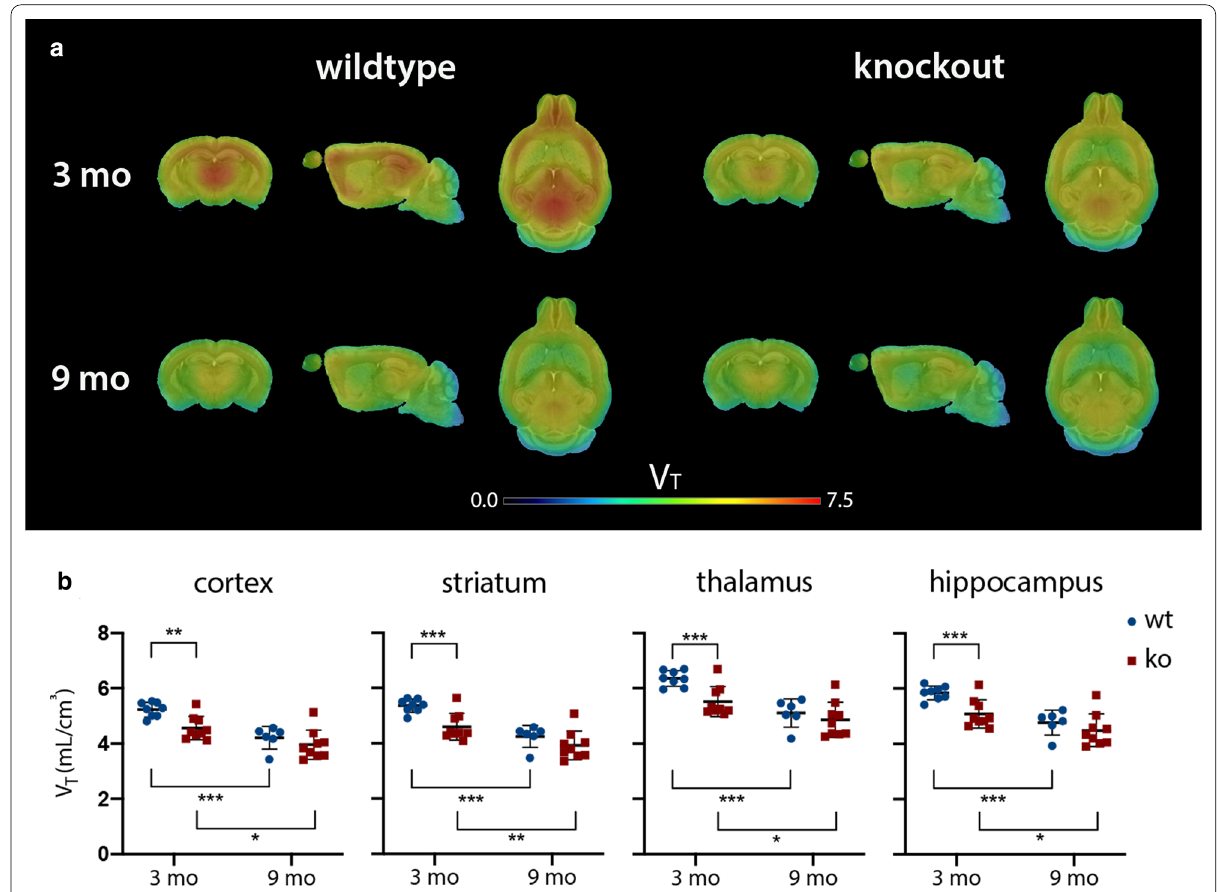
Fig. 2 a The averaged [ 11 C]UCB-J PET V T(IDIF) maps superimposed on a mouse MR template at 3 and 9 mo for both genotypes, b combined with the corresponding averaged [ 11 C]UCB-J PET V T(IDIF) values SD. Young adult Sapap3 ko mice are characterized by a lower synaptic density availability in ± the cortex, the striatum, the thalamus, and the hippocampus when compared to their wt counterparts. Also, both genotypes show a progressive decline in synaptic density availability with ageing, which was more pronounced in the wt controls. The corresponding averaged values be consulted in Additional file 1: Table 1. (ko, knockout; mo, months; MR, magnetic resonance; wt, wildtype; V T(IDIF) , volume-of-distribution; * p < 0.05, ** p < 0.01, *** p <